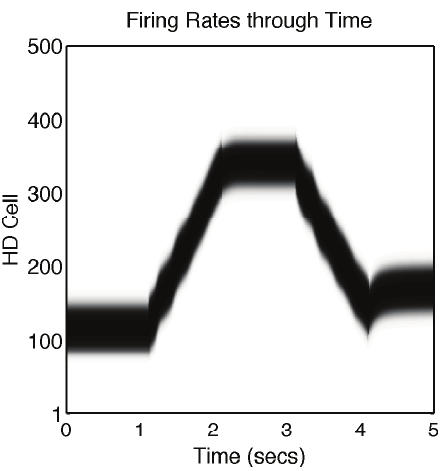
Figure 13. Path integration performance with a reduced number of rotational velocity cells. Firing rates of the head direction (HD) cells recorded during the testing phase of a model simulated with 25 % (125) of the rotational velocity cells deleted after training. The original model was trained with axonal conduction delays of 100 ms, at a rotational velocity of 180 0 /s. It is clear that the model can still perform the path integration of head direction even in a degraded state, and thus the model exhibits robustness to damage.